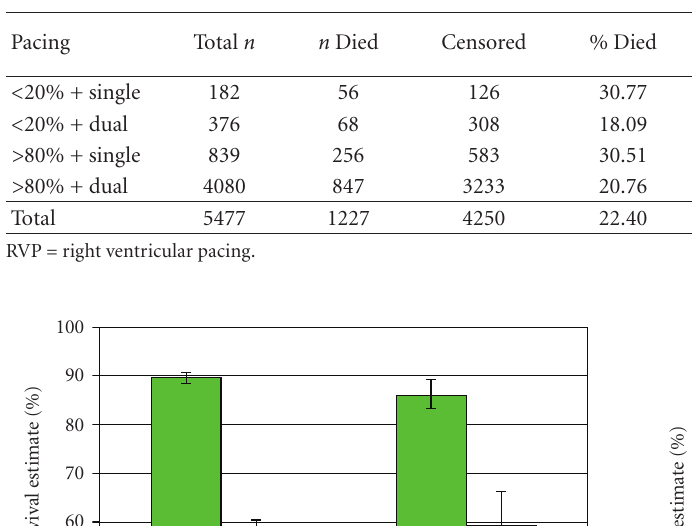
Table 6: Kaplan-Meier results for 4 groups.